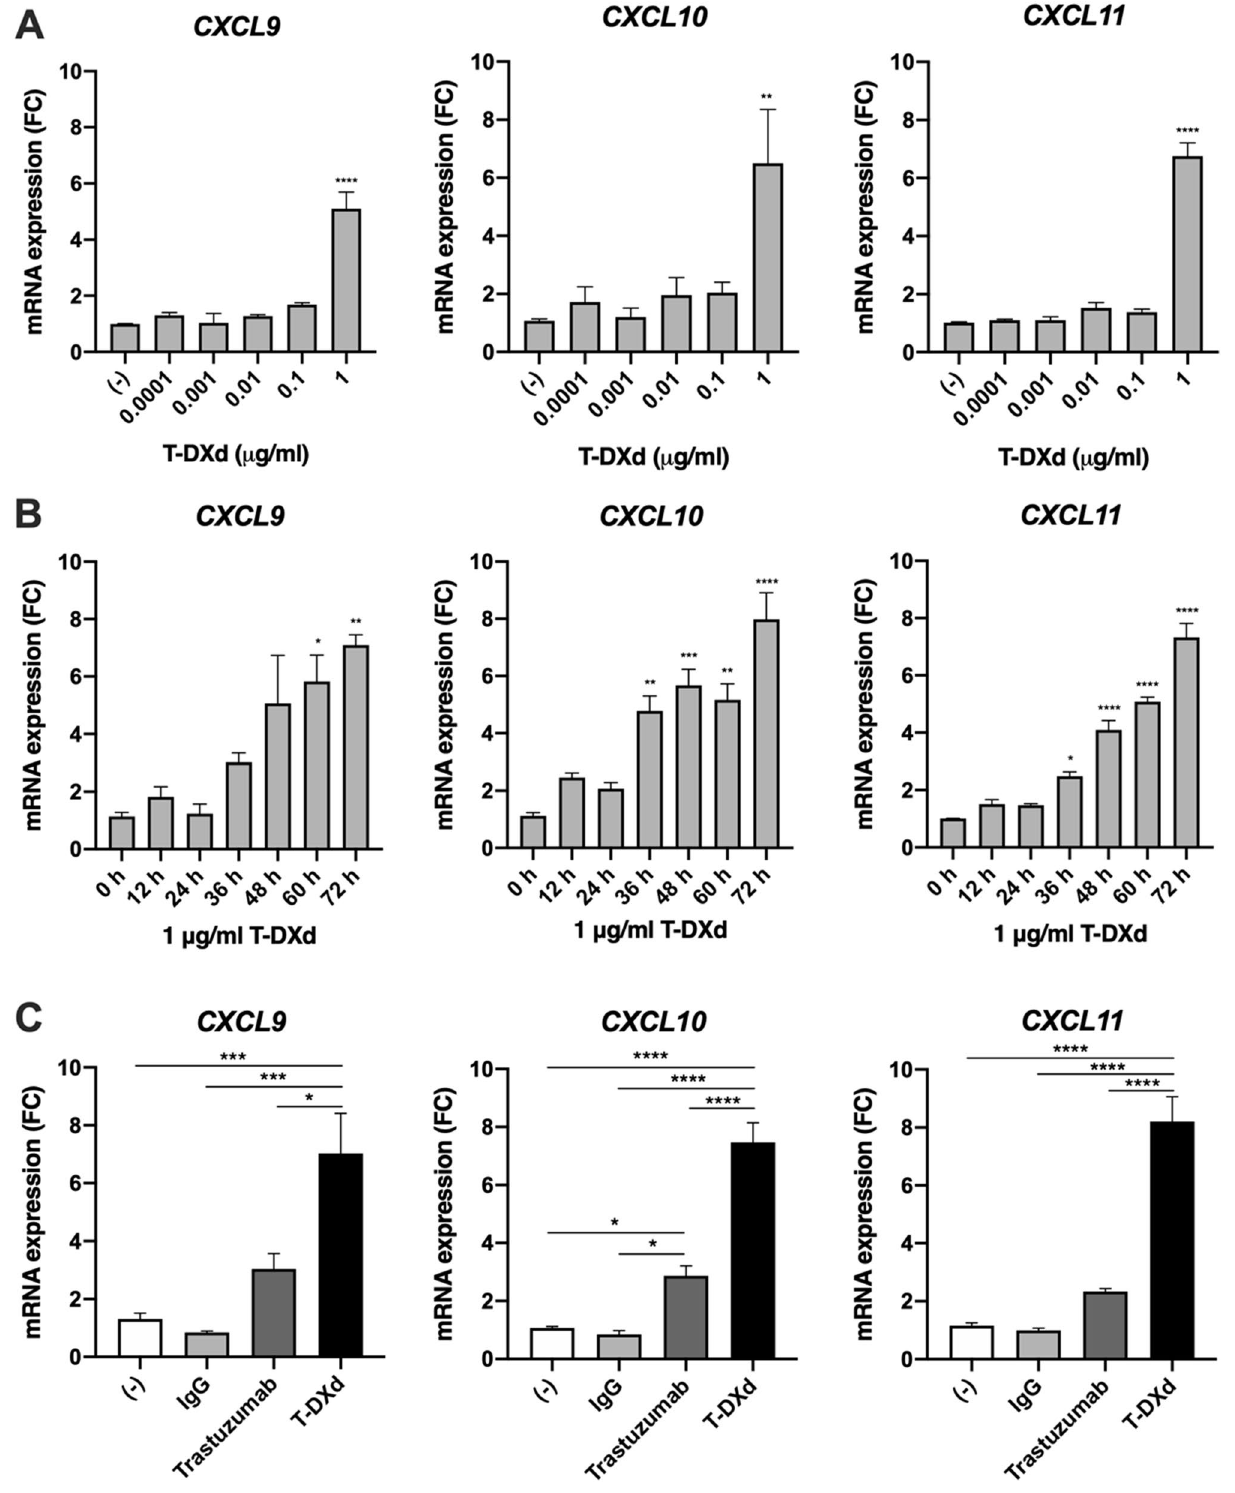
Figure 3. The effect of T-DXd on mRNA expression of CXCL9/10/11 in HER2-positive GC cells. ( A , B ) Dose- and time-dependent effect of T-DXd on mRNA expression of CXCL9 , CXCL10, and CXCL11 in NCI-N87 cells (n = 3). ( C ) mRNA expression of CXCL9 , CXCL10, and CXCL11 in NCI-N87 cells treated with 1 μg/ml human IgG, trastuzumab, or T-DXd (n = 3). Values are shown as means ± SEM. * P < 0.05, *** P < 0.001, **** P <